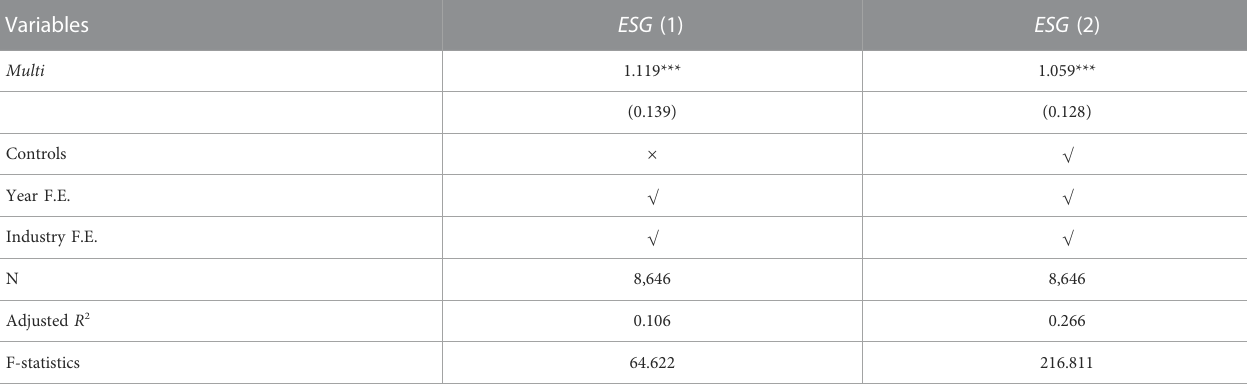
TABLE 5 Alternative measurements of MLS to verify the robustness.